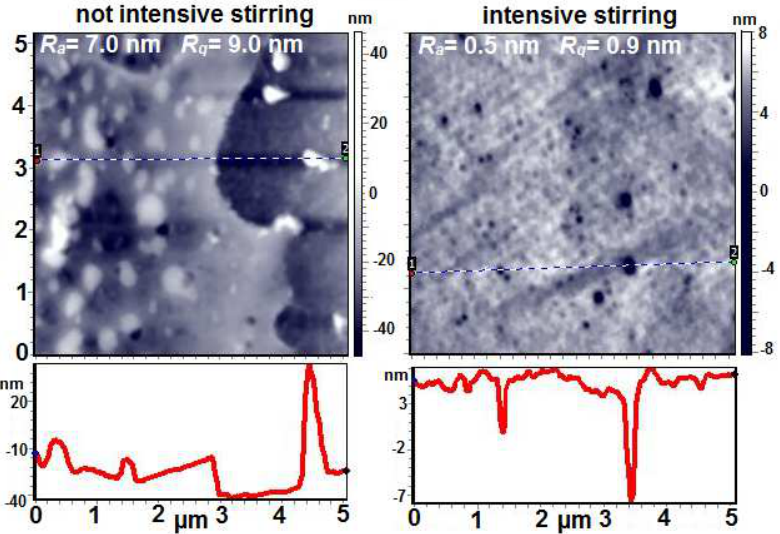
Figure 7. AFM height images and line profiles of PVA-PAA 80/20 (composition 1) and PVA-PAA 80/20 (composition 3).